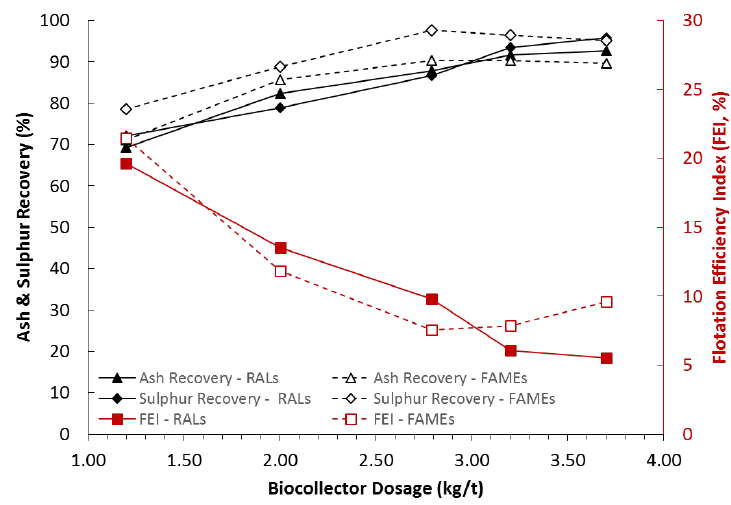
Figure 9. Ash recovery, sulphur recovery and FEI for Site 2 flotation experiments as a function of biocollector dosage at pH 2.7.